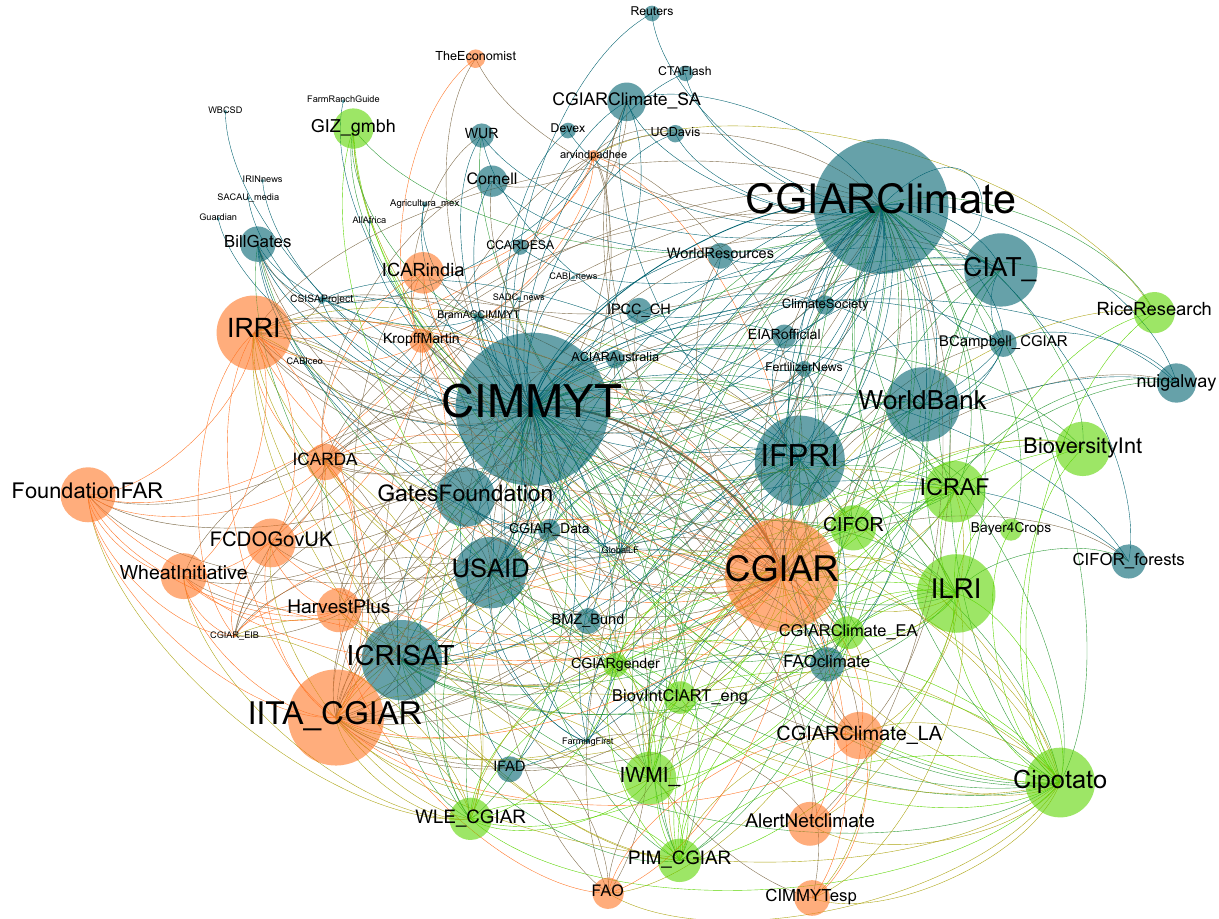
Figure 9. Top 75 influential nodes in Twitter mentions network (Parameters: force-directed graph, with node size partitioned as Eigenvector Centrality, colored by modularity class. Nodes = 75 accounts, edges = 518